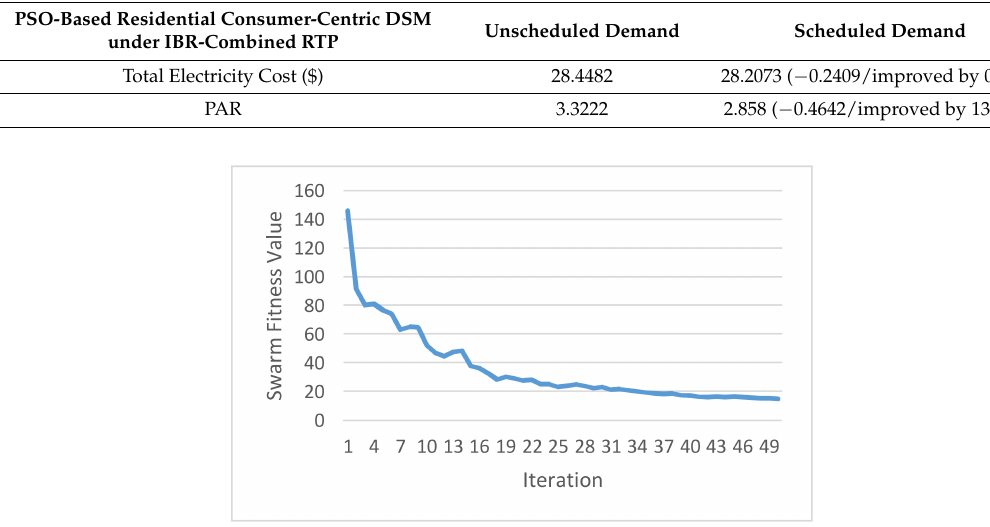
Figure 5. The optimal fitness value achieved and reported by the PSO was 15.070.